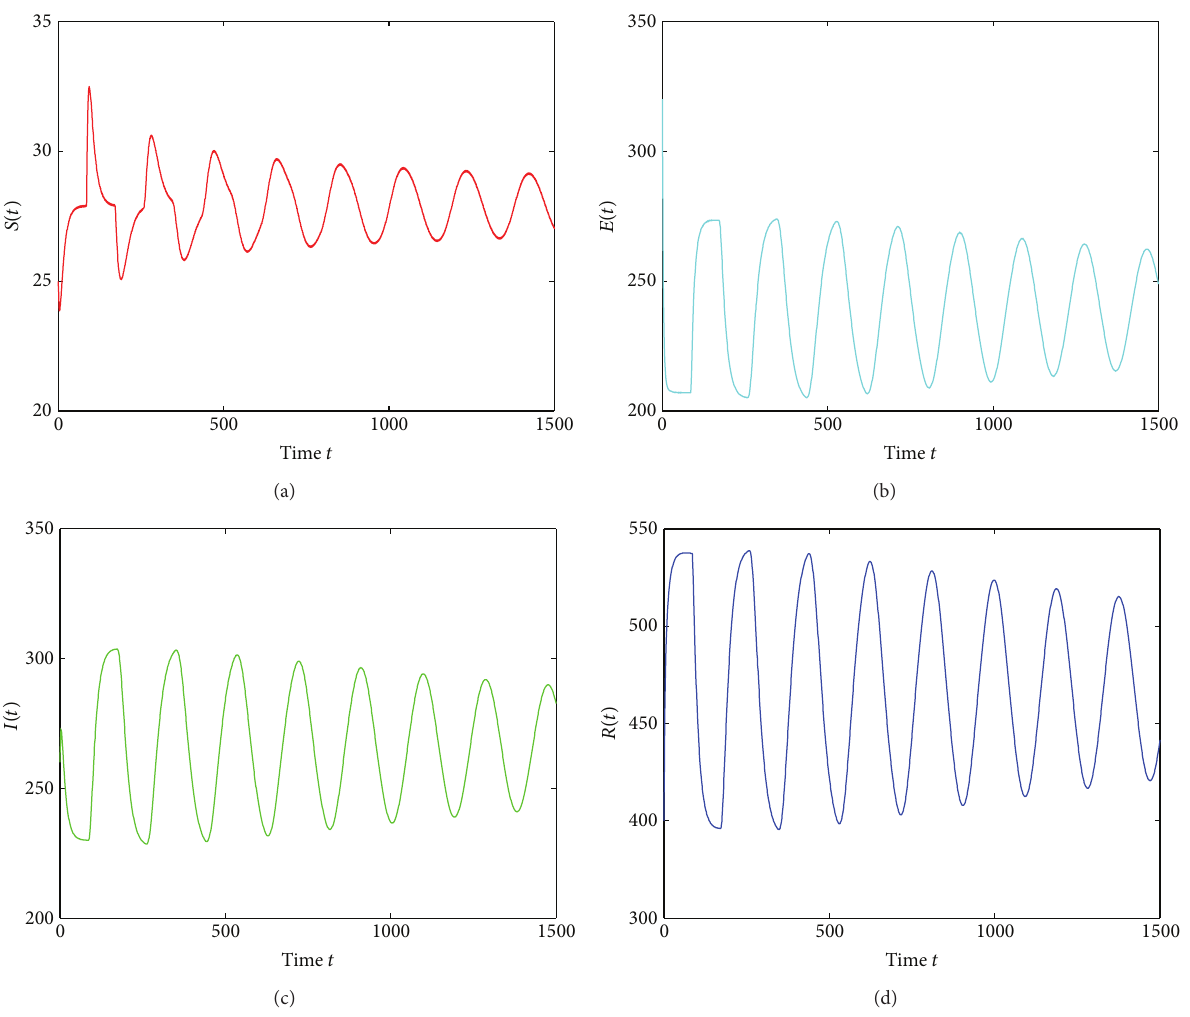
Figure 7: The track of the states 𝑆 , 𝐸 , 𝐼 , and 𝑅 for 𝜏 2 = 67.5000 > 52.4927 = 𝜏 20